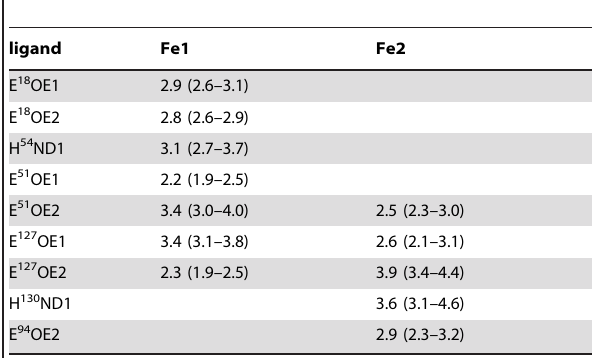
Table 1. Di-iron Site Interatomic Distances a